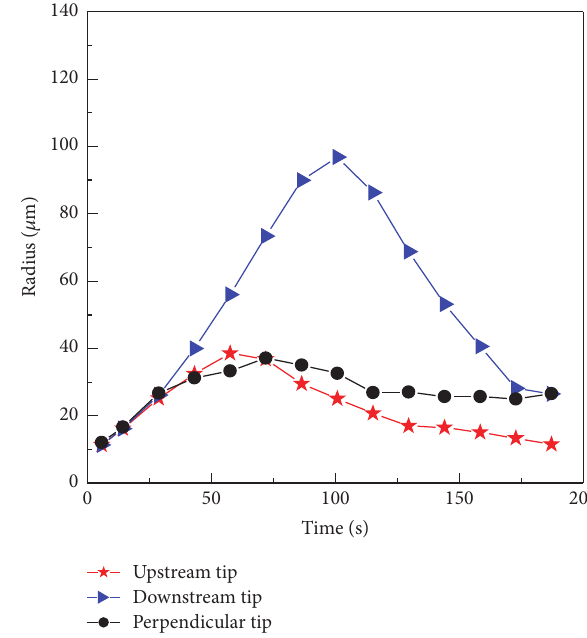
Figure 5: Evolution of the dendrite tip velocities of three different tips in the phase-field simulation. Figure 6: Evolution of the dendrite tip radii of three different tips in the phase-field